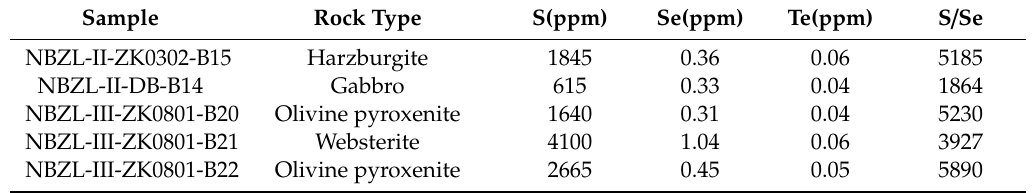
Table 5. Concentrations of S, Se, and Te from the Niubiziliang mafic-ultramafic complex. Sample Rock